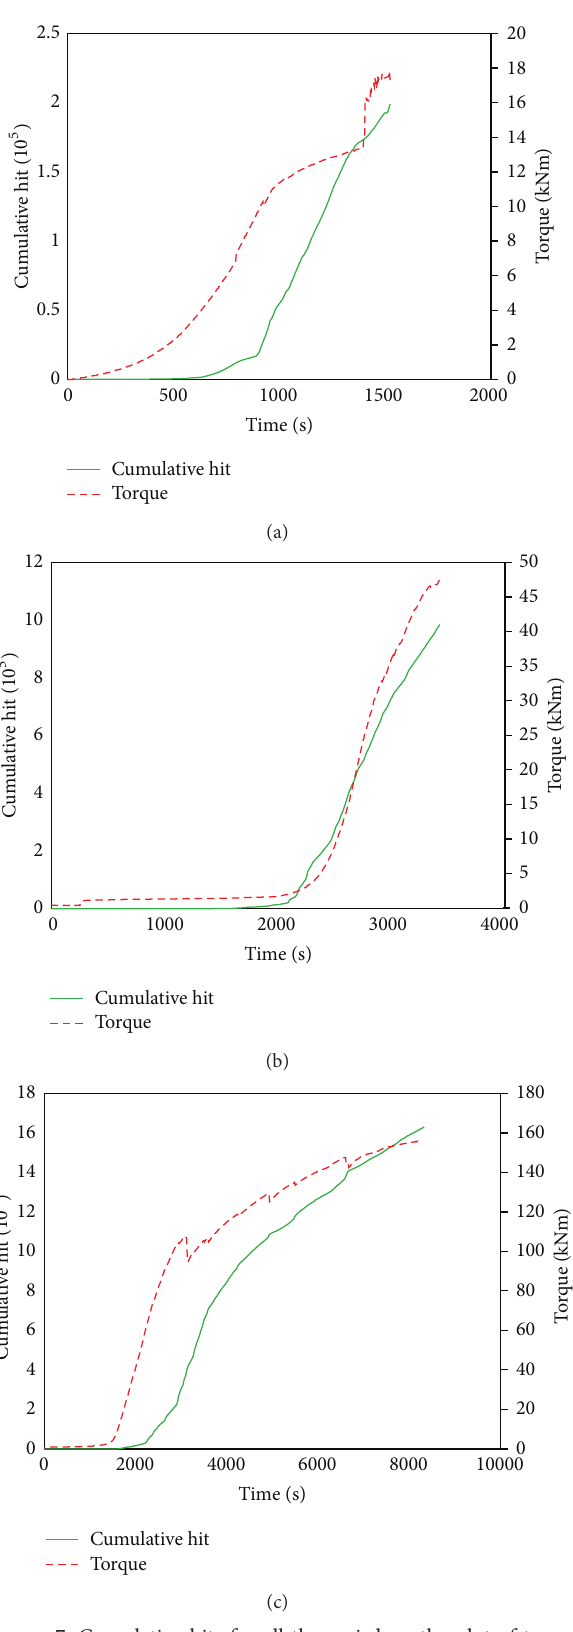
Figure 7: Cumulative hits for all three girders, the plot of torque moment is imposed. (a) Single cell section girder, (b) double cell section girder, and (c) triple cell section